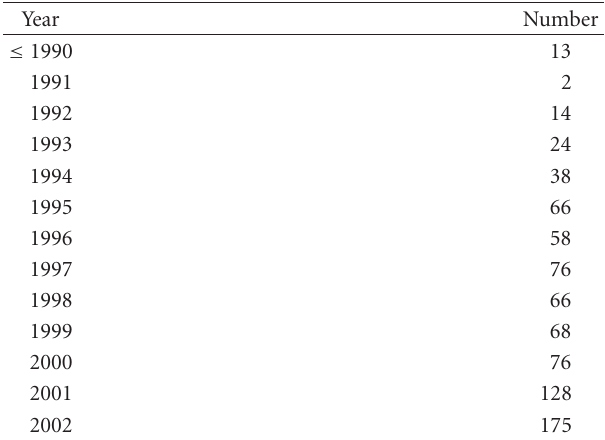
Table 1: Number of papers per year in medicine using fuzzy